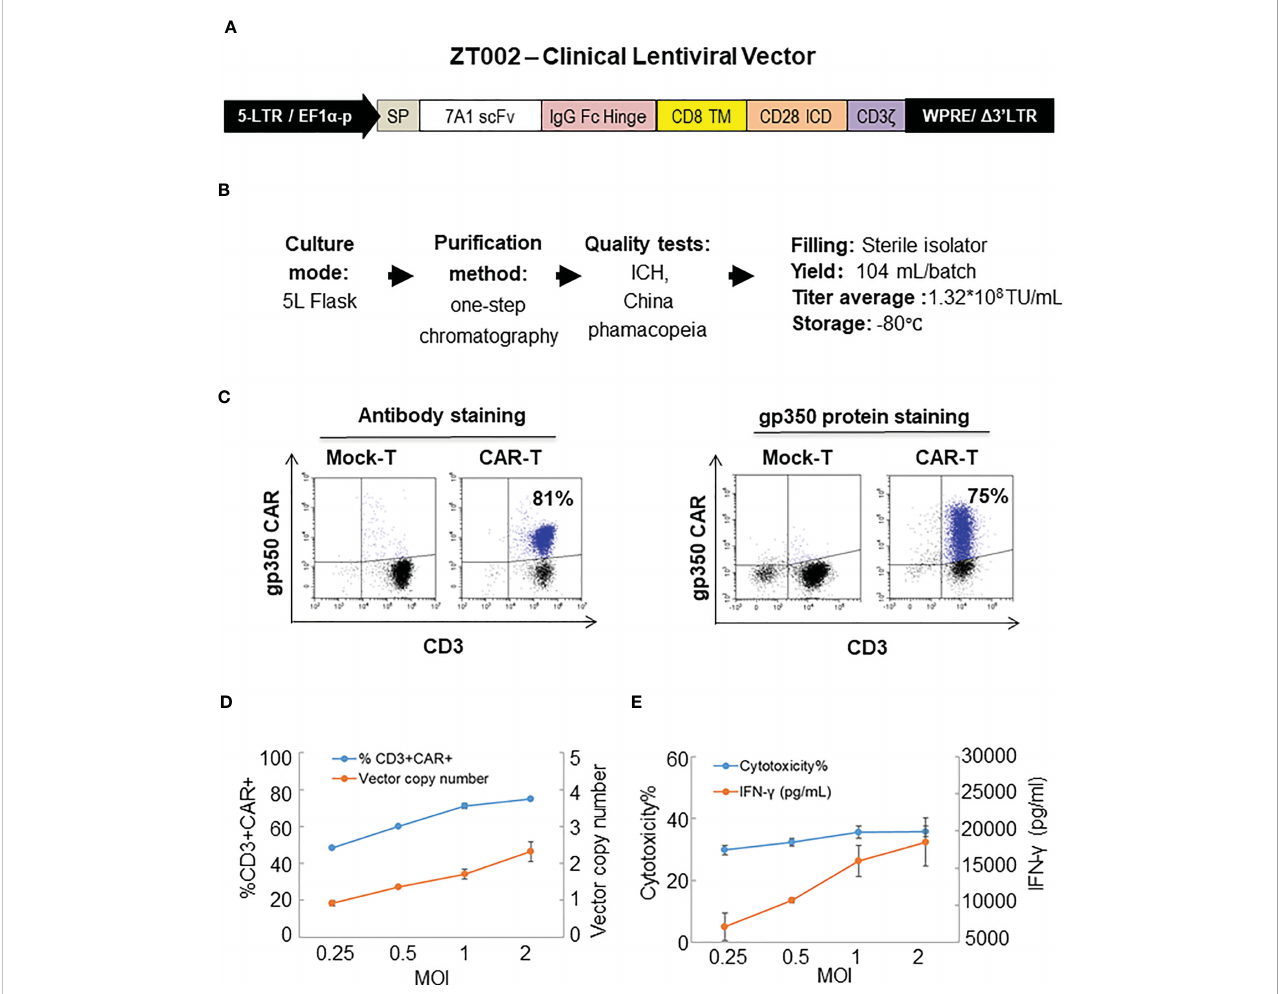
FIGURE 2 Production of ZT002 using GMP-compliant methods and generation of gp350CAR-T cells. (A) Detailed vector scheme of the self-inactivating third generation ZT002 vector selected for clinical use. The vector contains non-homologous 5 ’ and 3 ’ long-terminal repeats (LTRs). The 5 ’ LTR incorporates the EF1- a promoter and a WPRE element to improve the RNA stability upstream of the mutated ( D ) 3 ’ LTR. (B) Scheme of LV-ZT002 production, puri fi cation, testing and average results for three productions. (C) Flow cytometry detection of gp350CAR using an antibody for detection of the hinge (anti-IgG Fc, left) or labelled recombinant gp350 protein binding to the scFv (right). (D) Testing different transduction conditions with increasing multiplicity of infection (MOI) to correlate the ef fi ciencies of gp350CAR + T cell generation with the integrated vector copy numbers. PBMCs were stimulated on day 0, transduced on the next day with ZT002 at increasing MOIs (0.25, 0.5, 1 and 2), and ten days later analyzed for the percentages of CD3 + CAR + cells (blue line) and number of CAR copies per cell genome (orange line). (E) Testing the functionality of gp350CAR-T cells generated with different ZT002 MOIs for target cytotoxicity and correlation with IFN- g production. CAR-T cells were co-cultured with PCI-1/gp350 (E:T=2.5:1) and IFN- g released in medium (orange line) and cytotoxicity activity (blue line) were analyzed. Results of independent triplicate experiments, performed with gp350CAR-T cells produced with one PBMC